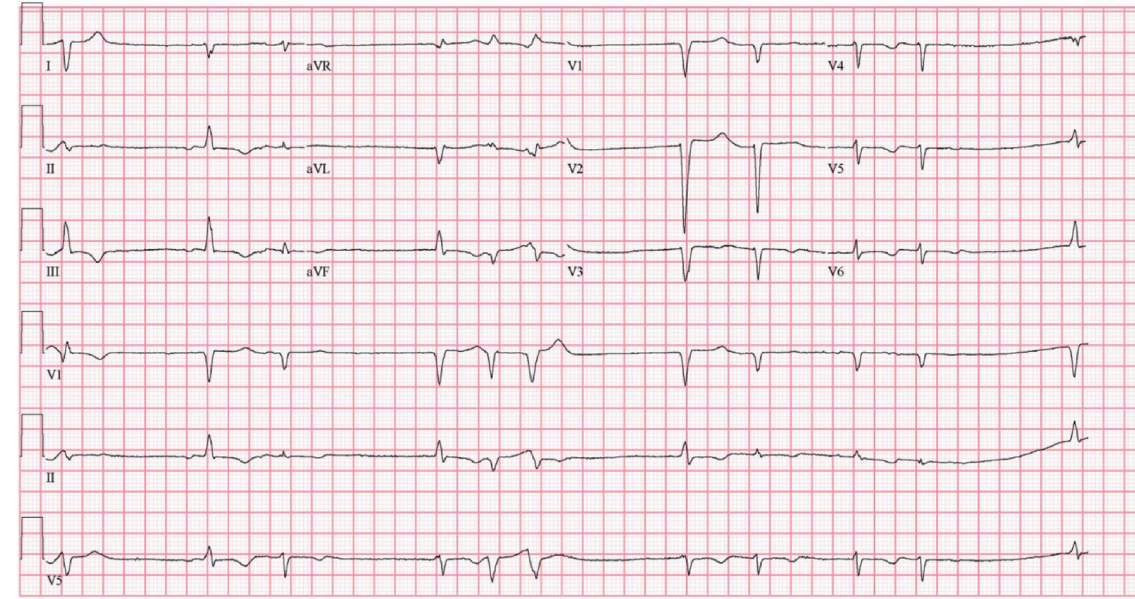
Figure 3: Electrocardiogram after cardiac arrest with junctional bradycardia and premature ventricular complexes.